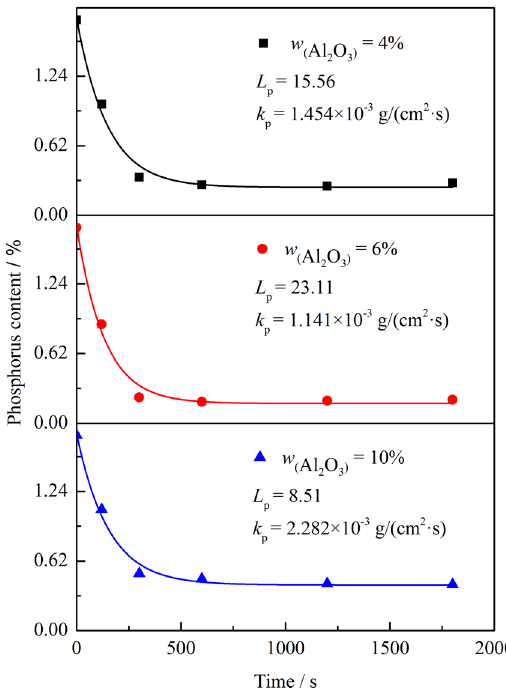
Figure 2: Fitting curves of the P content of the fi nal iron sample as a function of time with the FeO content ranging from 45 to 60%.